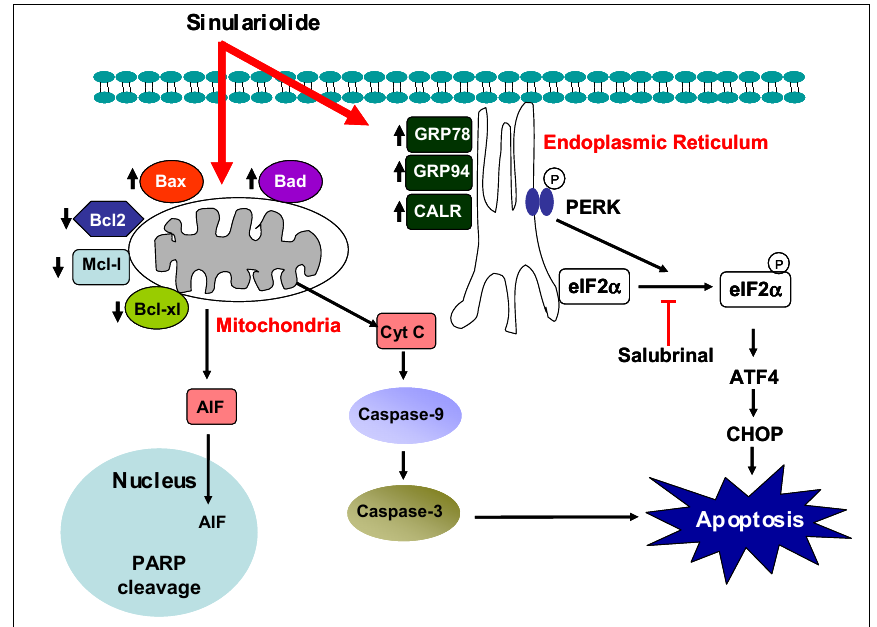
Figure 7. Illustration of how sinulariolide induces cellular apoptosis through mitochondrial-related apoptosis and PERK/eIF2 α /ATF4/CHOP pathway on HA22T cells. Sinulariolide Sinulariolide